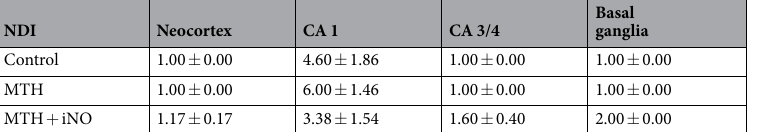
NDI Neocortex CA 1 CA 3/4